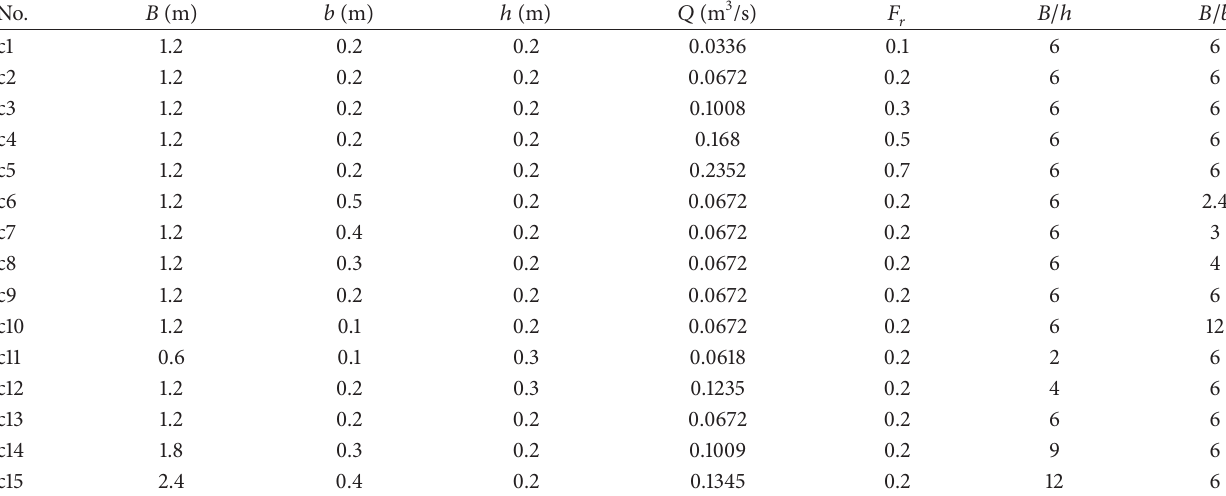
Table 2: Simulation